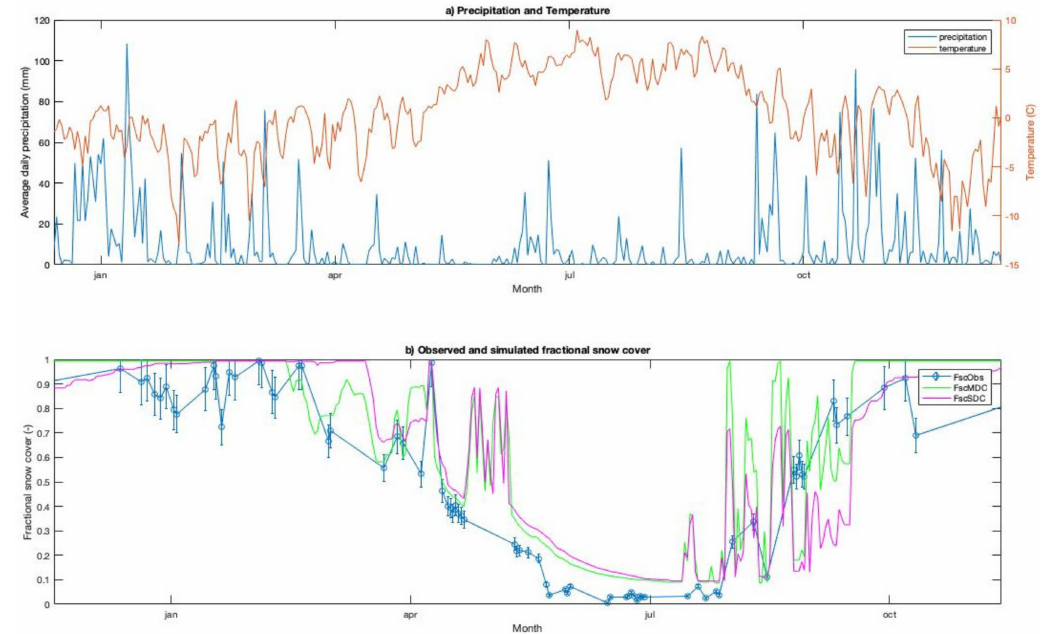
Figure 5. Observed and simulated precipitation, temperature, and fractional snow cover area during the validation period (2014). ( a ) Observed temperature and precipitation data from the Harmonie dataset [46]. ( b ) Observed and simulated fractional snow cover using single-dataset and multi-dataset calibration (MDC and